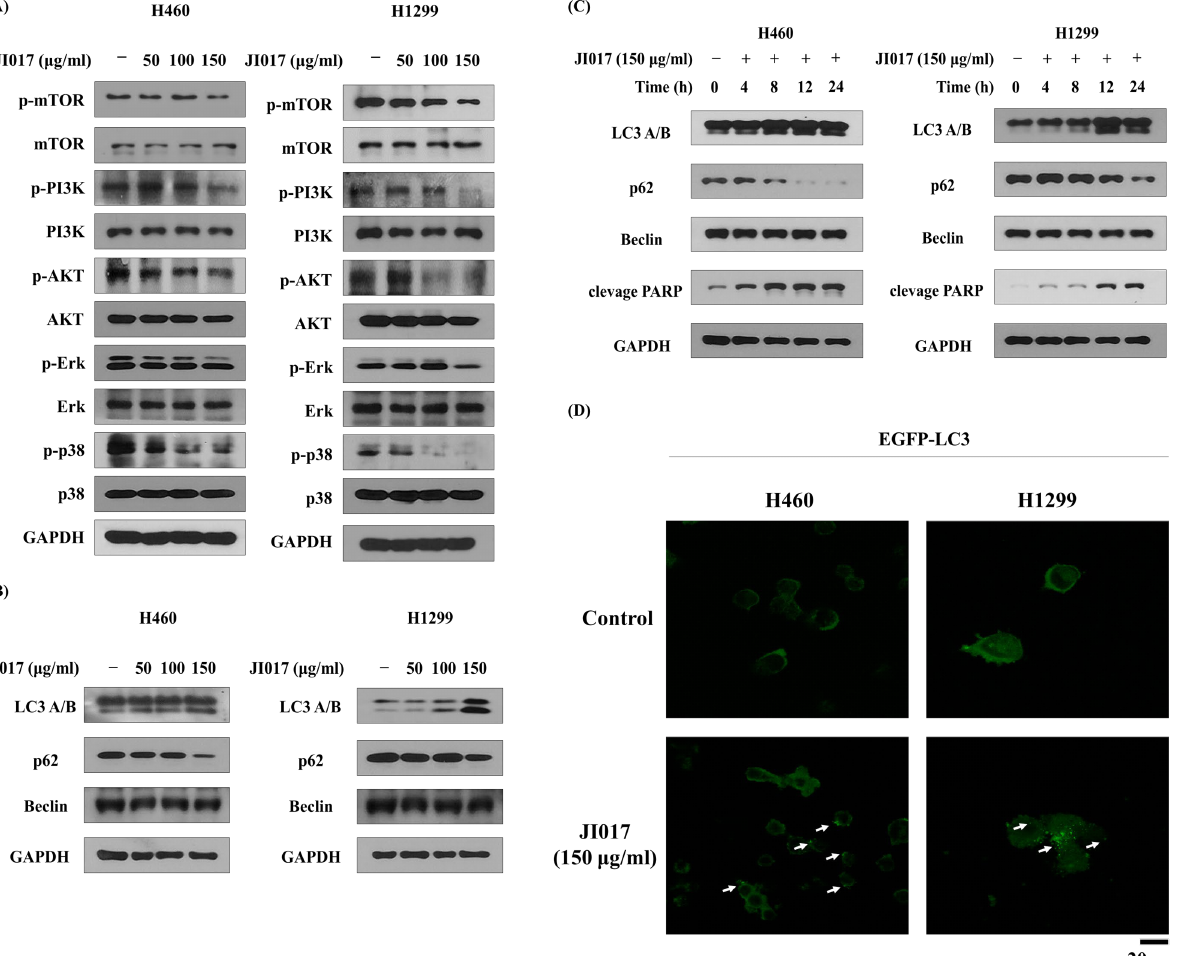
Figure 3. JI017 activated autophagy by suppressing the PI3K-AKT-mTOR pathway in H460 and H1299 cells. H460 and H1299 cells were treated with JI017 (50, 100, and 150 µg/mL) for 24 h. ( A , B ) Whole cell lysates were analyzed by Western blotting. ( C ) H460 and H1299 cells were treated with JI017 (150 ng/mL) for different times (4, 8, 12, and 24 h). ( D ) H460 and H1299 cells transfected with the pEGFP-LC3 vector were treated with JI017 (150 µg/mL) for 8 h. The Fluorescence microscopy analysis confirmed positive staining of LC3B puncta. LC3B puncta are indicated by white arrows. Scale bar = 20 µm.